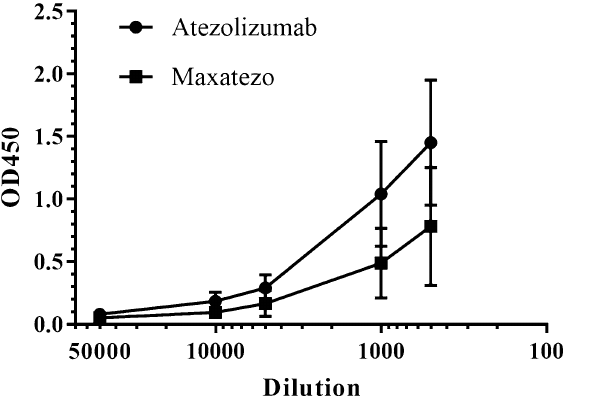
Figure 5. Maxatezo has lower immunogenicity than Atezolizumab in mice. Immunogenicity of antibodies was assessed using an in vivo mouse model (n = 5) and the ADA titers were measured using Indirect ELISA against antibody drugs. Data are presented as mean ± SD. The line with squares represents the Maxatezo, (anti-PD-L1 antibody with GGGS insertion), the line with circles represents the Atezolizumab (anti-PD-L1 antibody with N297A). The horizontal coordinate is the antibody dilution ratio and the vertical coordinate is the absorbance value at 450 nm.